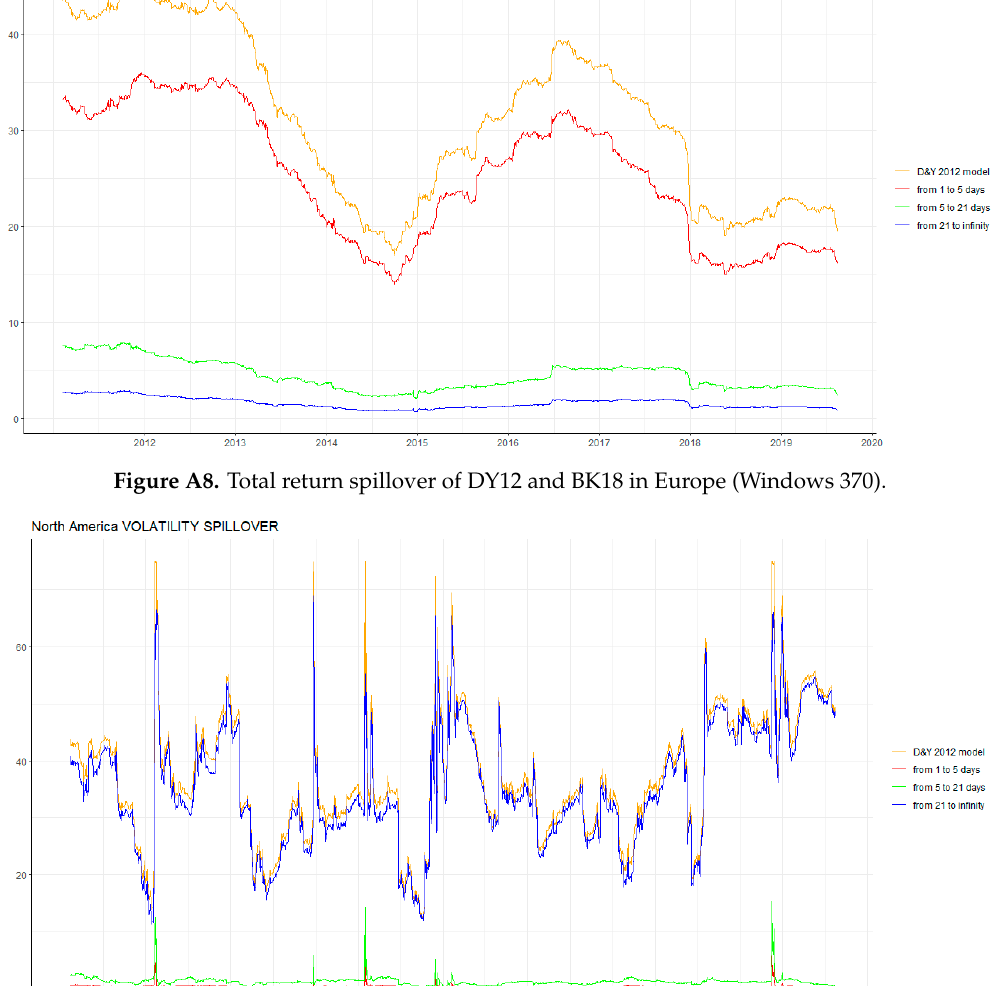
Figure A9. Total volatility spillover of DY12 and BK18 in North America (Windows 250).